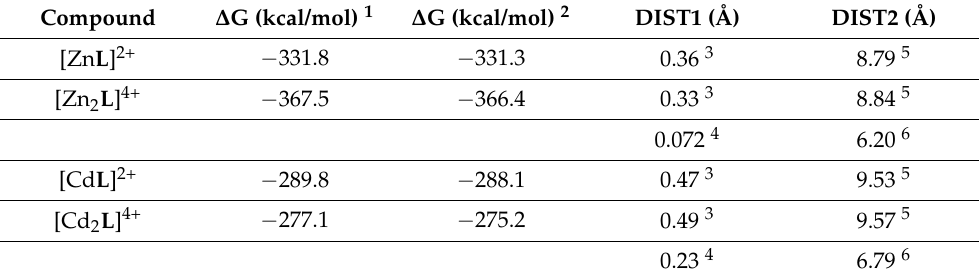
Table 1. Results of reactions 1 and 2 obtained by DFT calculations for Zn 2+ and Cd 2+ complexes of L